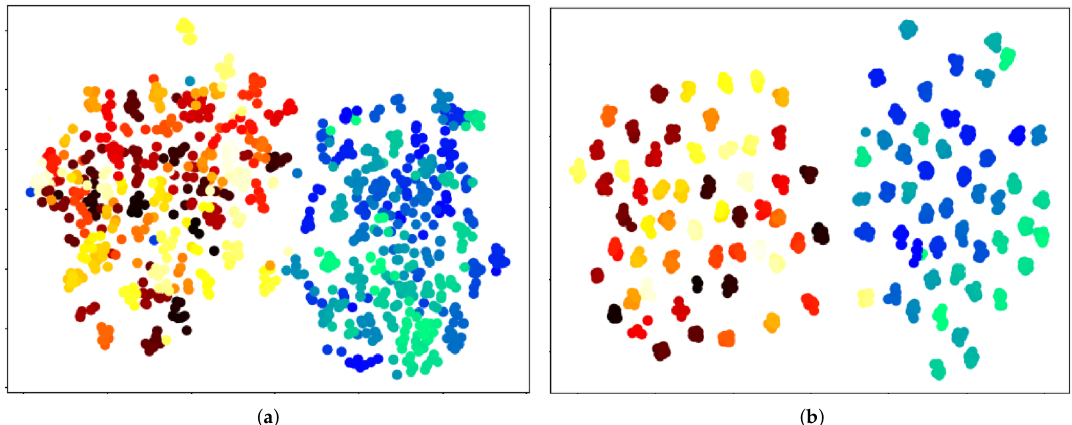
Figure 5. Visualizing Average embeddings vs. Supervectors for 1 phrase from male+female using T-Distributed Stochastic Neighbor Embedding (t-SNE), where female is marked by a cold color scale and male is marked by a hot color scale. ( a ) average embeddings; ( b ) supervectors.